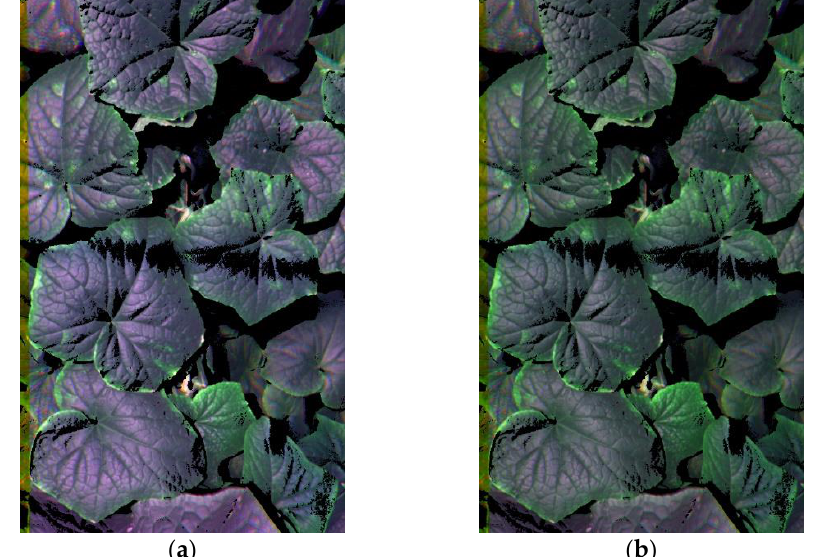
Figure 5. Comparison between ( a ) aligned and masked RGB cucumber canopy images and ( b ) the same image after applying the illumination correction.